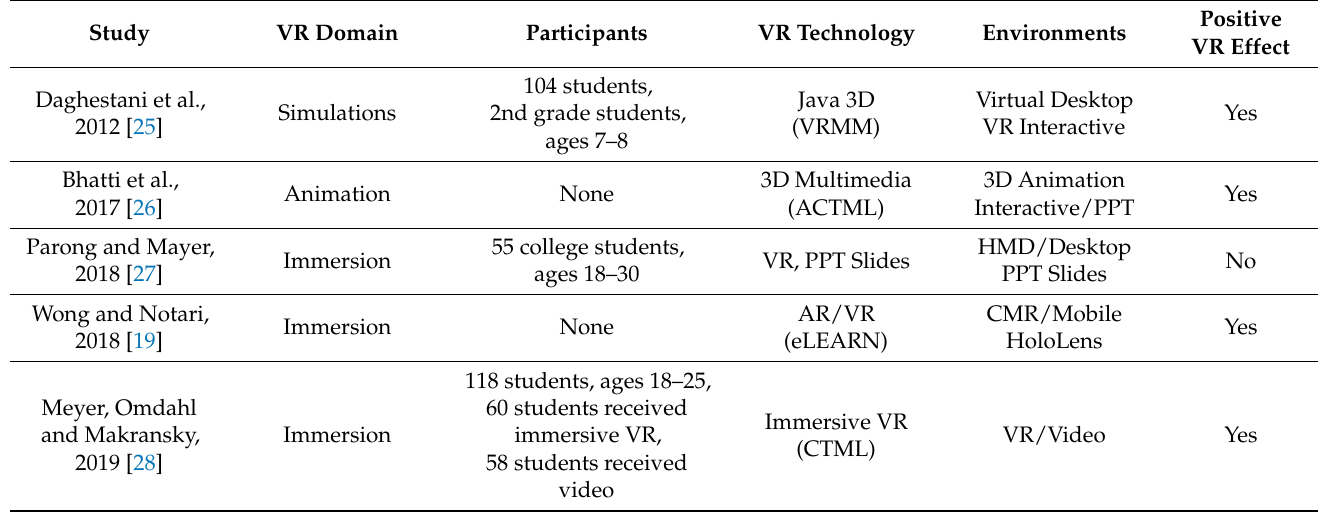
Table 2. Overview of experimental studies on VR-based CTML for teaching and